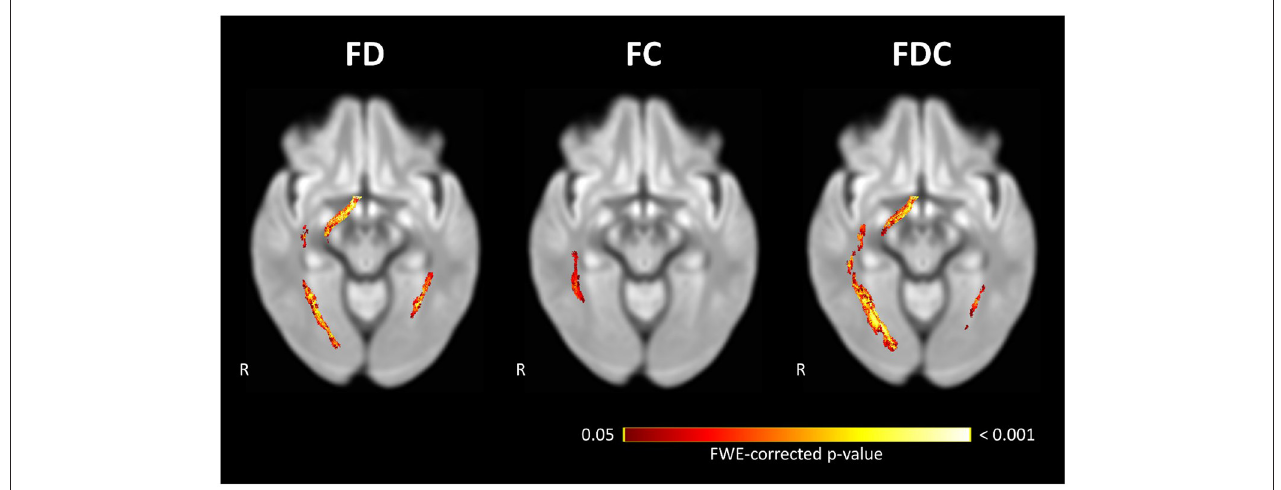
FIGURE 3 | Significant loss of FD, FC, and FDC in the visual pathways of POAG patients between Time-point 1 and Time-point 2. Repeated measures analysis of POAG patients reveals a significant loss of FD and FDC at the right OT and both ORs, and a significant loss of FC in the right OR. Streamlines corresponding to fixels exhibiting significant (FWE-corrected P < 0.05) loss are overlaid on a representative axial slice of the inter-subject population template and colored according to their p -values. Images are shown in radiologic convention. FC, fiber-bundle cross section; FD, fiber density; FDC, fiber density and bundle cross section.